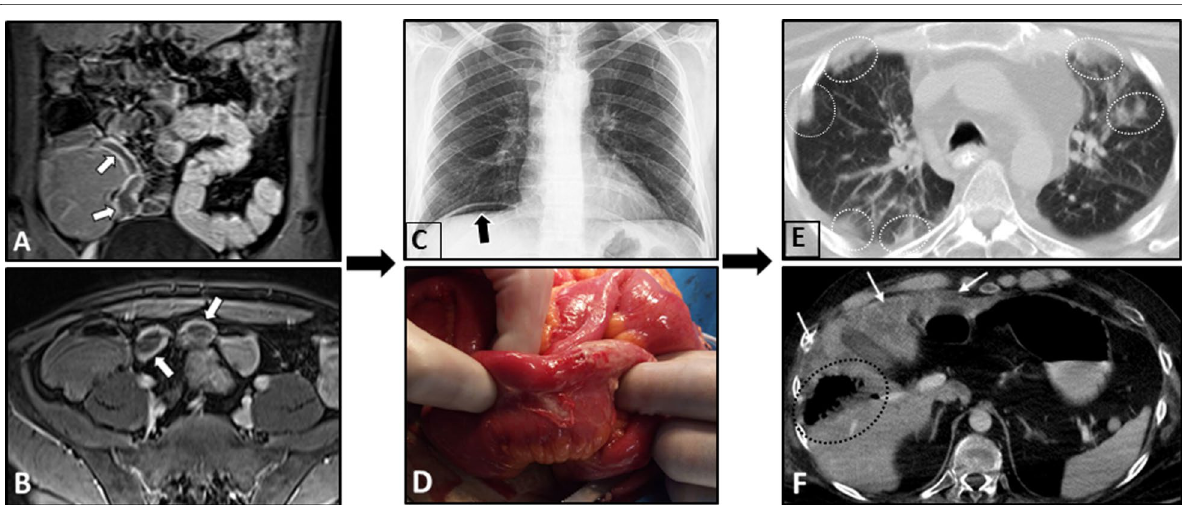
Fig. 10 Intestinal vasculitis and perforation in a 32-year-old male with a history of asthma presenting with abdominal pain and eosinophilia. MRE was obtained. Coronal and axial post-contrast T1-W images ( A , B ) display increased mural enhancement at the terminal ileum without thickening (thick white arrows). Three months later ( C , D ), the patient presents to the ER with acute abdominal pain without definite diagnosis or treatment. Chest X-ray ( C ) shows subdiaphragmatic free gas (thick black arrow). He underwent an emergency laparotomy. Intraoperative photograph ( D ) revealed focal bowel perforation at the distal ileal segment. After segmental bowel resection, an ileostomy was performed. Eight months after surgery (E, F), he was admitted for RUQ pain and dyspnea. Axial chest CT image ( E ) demonstrates bilateral GGO and consolidations with lobular distribution (white dotted oval). Axial contrast-enhanced CT image ( F ) shows multiple wedge-shaped areas of hypoattenuation in the liver (thin white arrows), consistent with hepatic infarction. Intraparenchymal gas formation is also evident at the infarcted segment, suggestive for